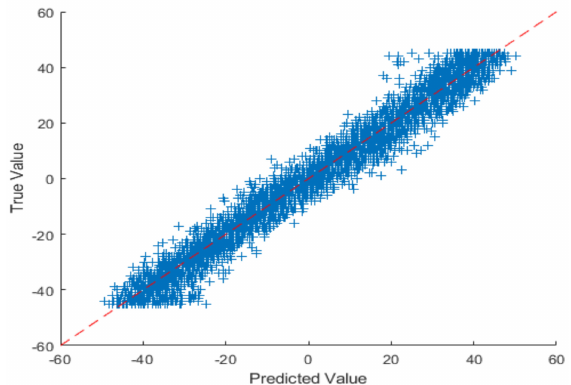
Figure 16. Eye gaze estimation model